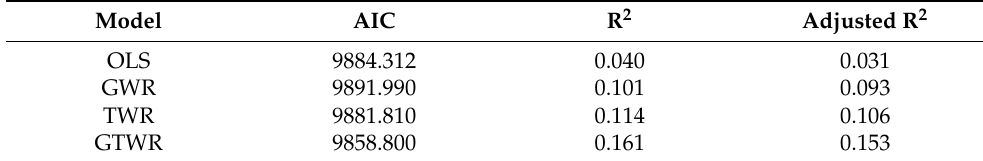
Table 3. Comparison of different models.